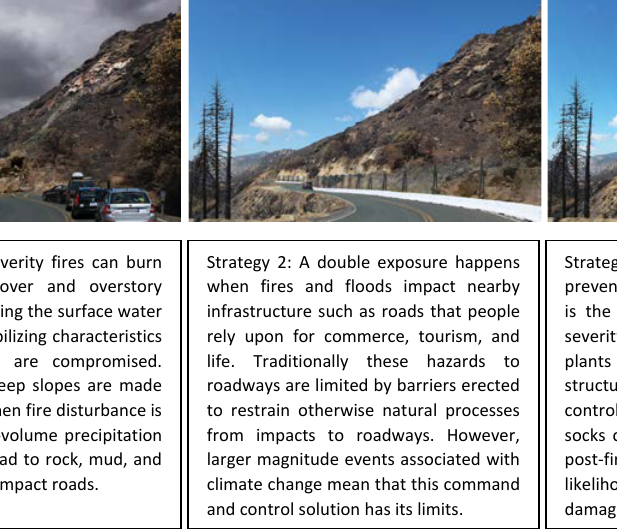
Strategy 1: Post-fire/flood landslide Strategy 2: Post-fire/flood landslide